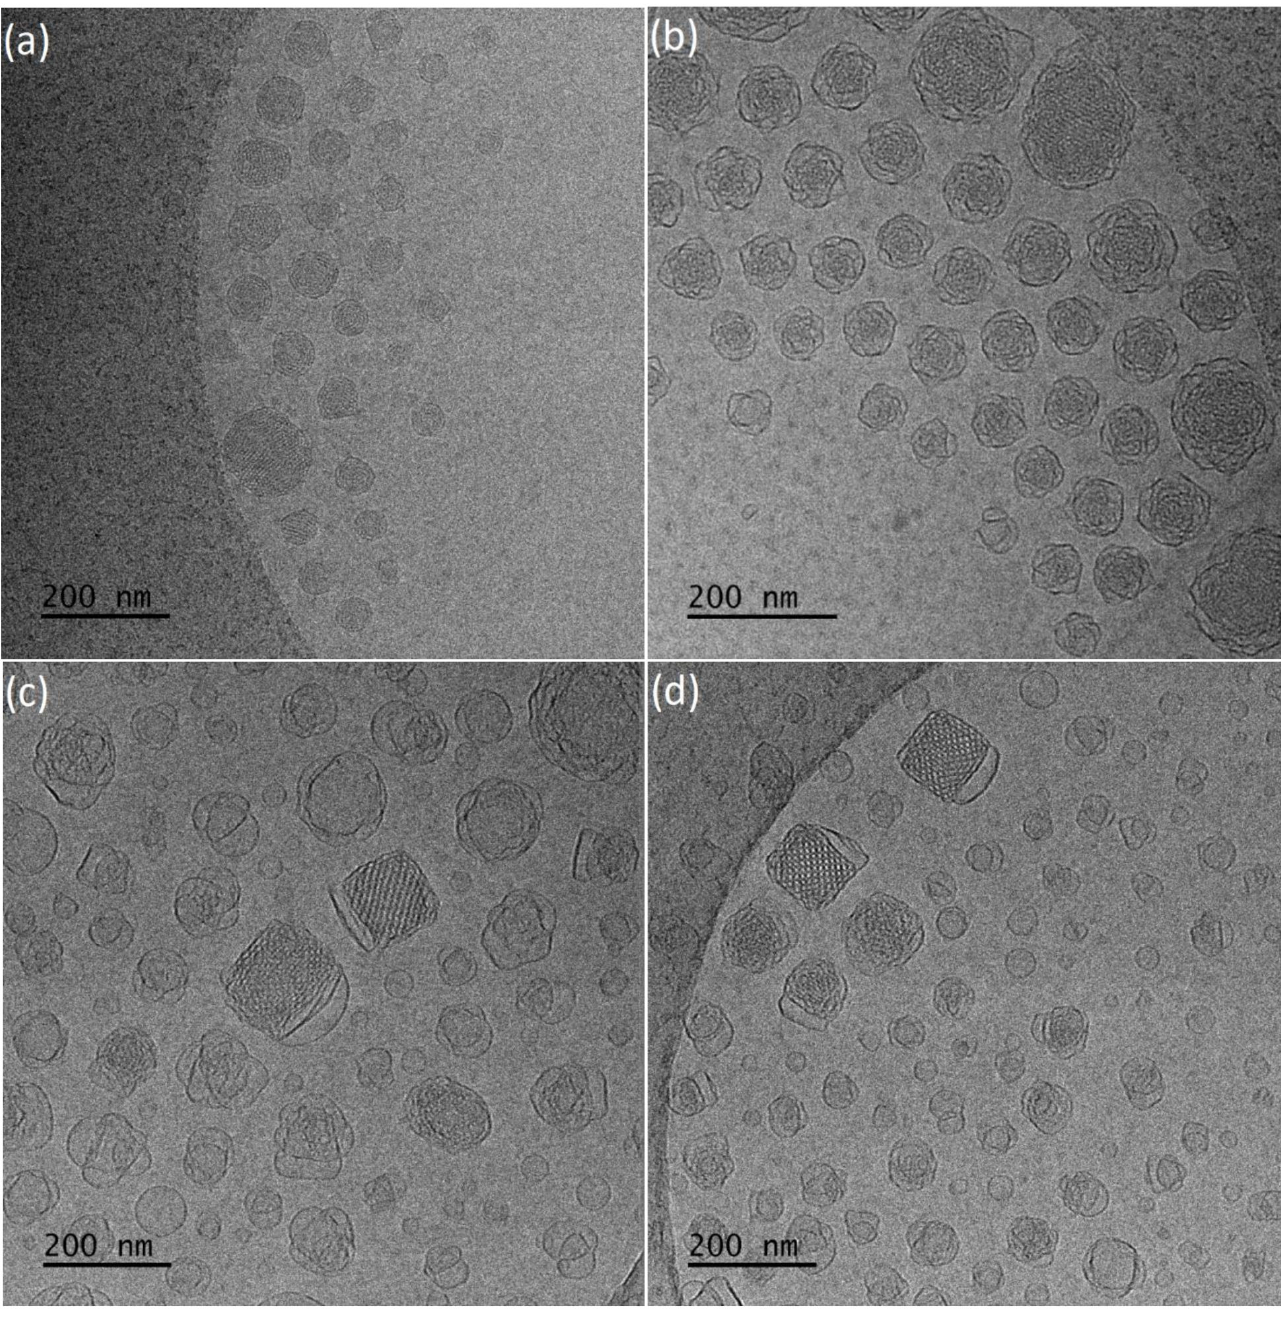
Figure 2. Representative cryo-TEM images of the ( a ) GMO:PEO- b -PLA 9:1, ( b ) GMO:PEO- b -PLA 4:1, ( c ) GMO:PEO- b -PMEC 9:1, ( d ) GMO:PEO- b -PMEC